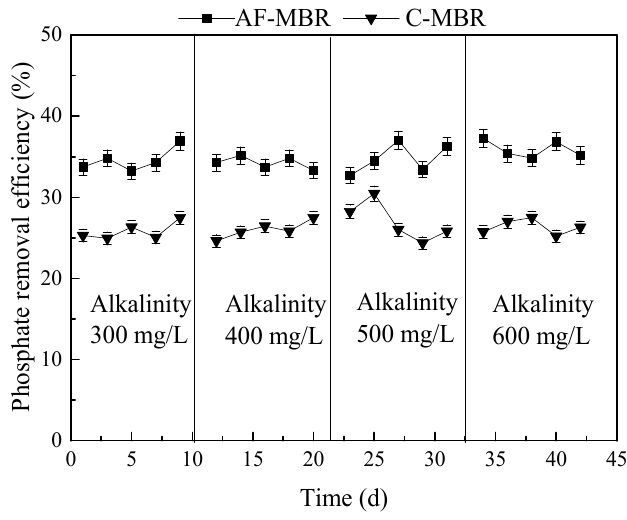
Figure 6. Influence of different influent alkalinity values on phosphate removal efficiency.